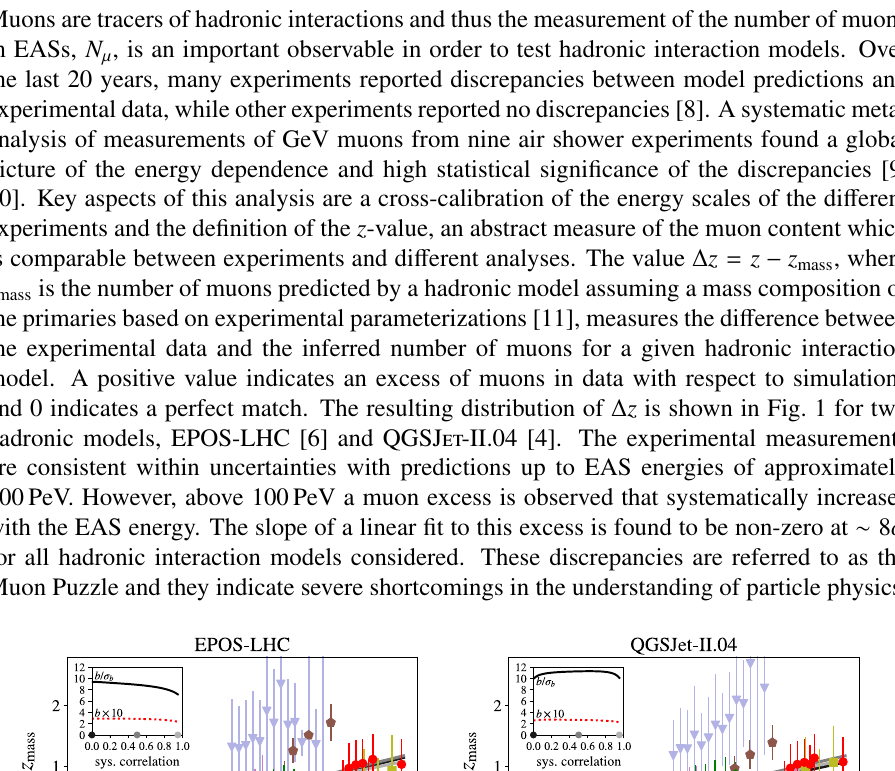
Figure 1. Linear fits of the form ∆ z = a + b described in Ref. [9]. Shown in the inset are the slope, b , and its deviation from zero in standard devia- tions for an assumed correlation of the uncertainties within each experiment (for details see Ref. [10]). Examples of the fits are shown for a correlation of 0 . 0, 0 . 5, and 0 . 95 in varying shades of gray.